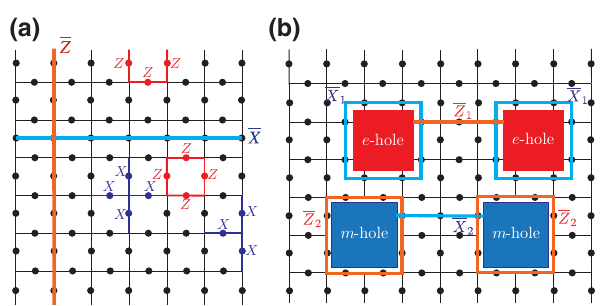
FIG. 4. (a) The surface code and two types of gapped bound- aries: the horizontal (vertical) e -boundaries ( m -boundaries) con- dense e -anyons ( m -anyons) such that the logical Z -string ( X - string) can terminate on them. (b) Two types of holes. The e -hole ( m -hole) has e -boundaries ( m -boundaries), which trap a logical X -loop ( Z -loop) around it, and allows a logical Z -string ( X -string) to terminate on